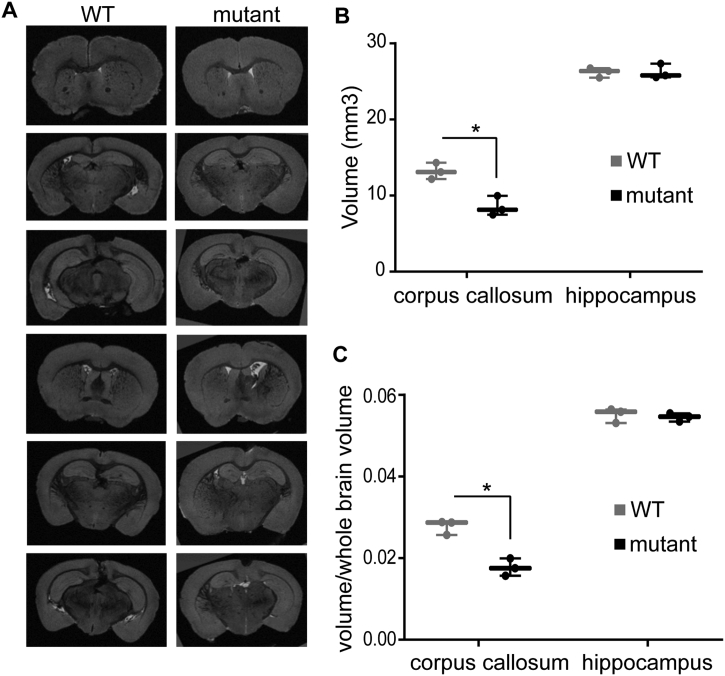
MRI analysis of brains from WT and Zdhhc9 mutant mice. (A) Coronal images from WT and mutant mouse brains after ex vivo MRI scan in a 9.4 Tesla magnet. (B and C) Box and whiskers graphs showing the various data points for the volume of corpus callosum and hippocampus. The whiskers indicate the maximum and minimum data points while the thick horizontal line indicates the median. (B) without normalisation; (C) with normalisation to total brain volume (n = 3 WT, 3 mutant).